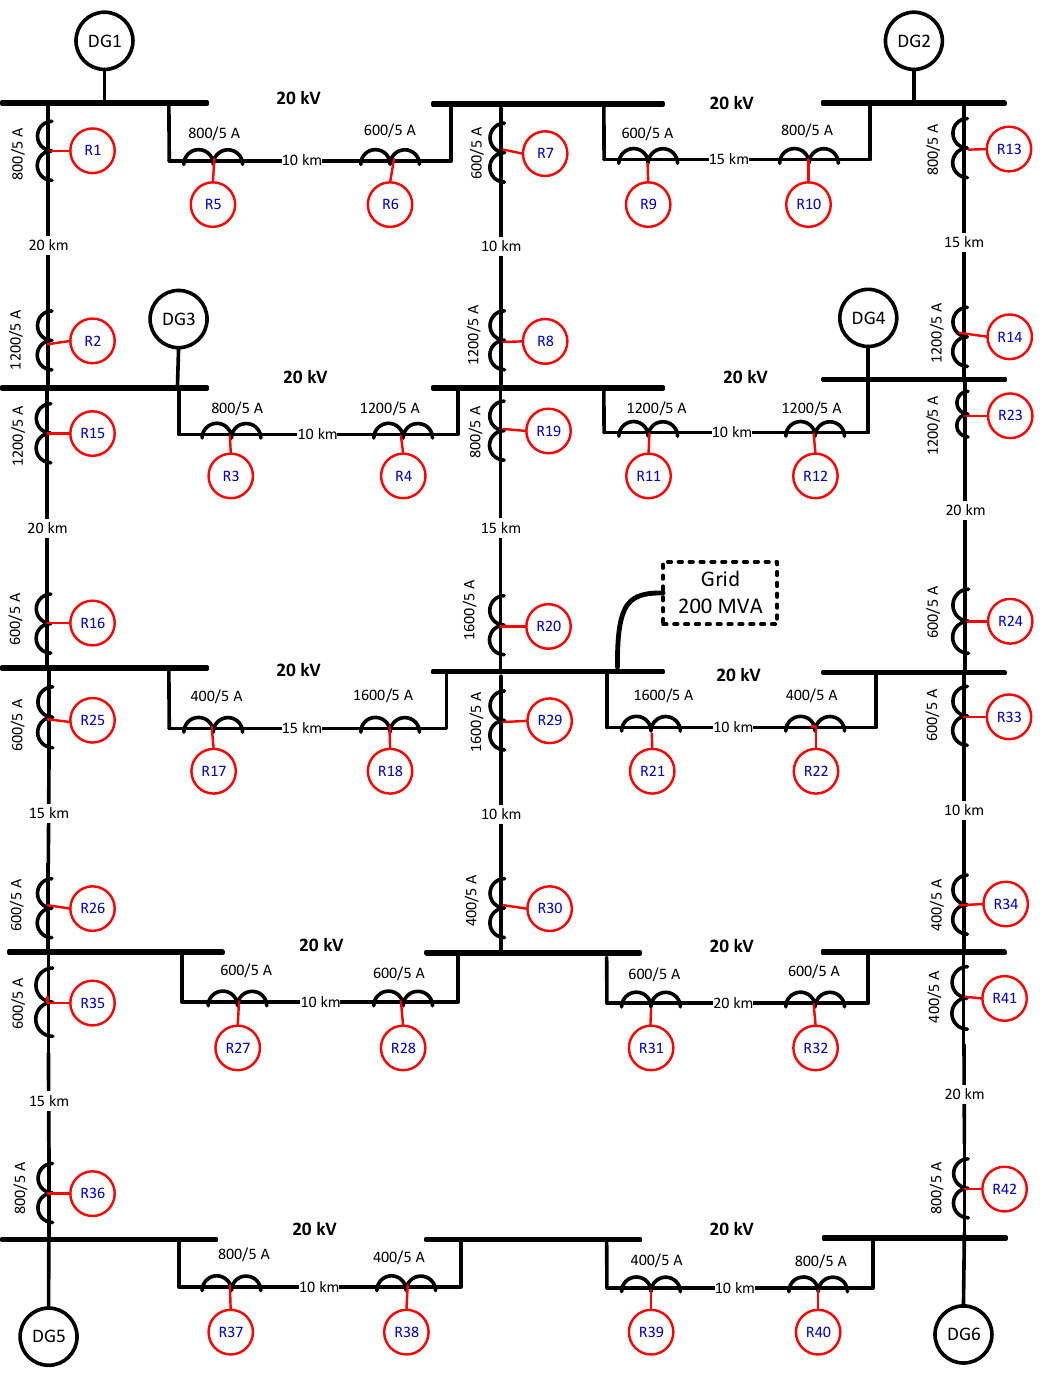
Figure 3. The SLD of the IEEE 15-bus network. To validate the GTO results, the following assumptions are considered for a fair com- parison with other algorithms: (i) an OLC between 100% to 150% of the full load current with no considerations on the minimum fault current conditions, the (ii) T Di , min = 0.05